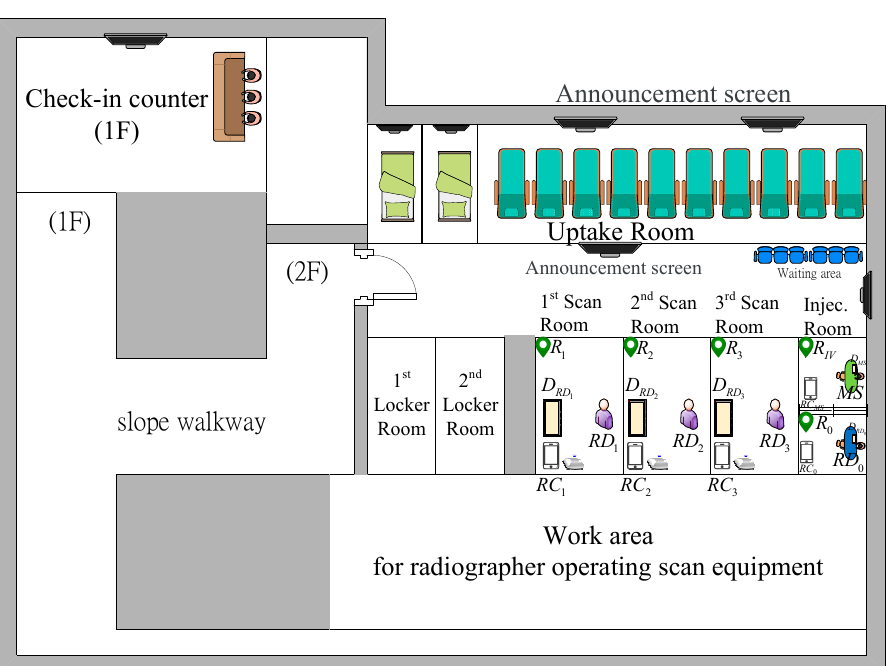
Figure 11. PET outpatient area layout of Linkou Chang Gung Hospital.